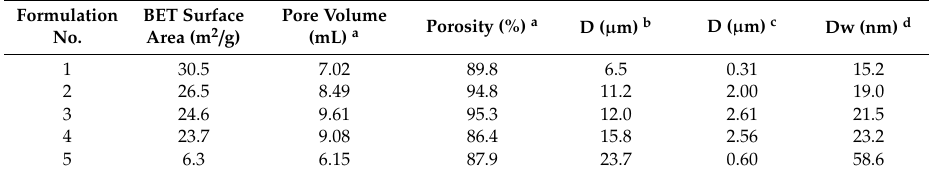
Figure 2. SEM images of PolyHIPE Scaffolds fabricated with W/O ratio of ( a ) 80/20, ( b ) 85/15 and ( c ) 90/10. Table 2. Characterization of the polyHIPE materials.